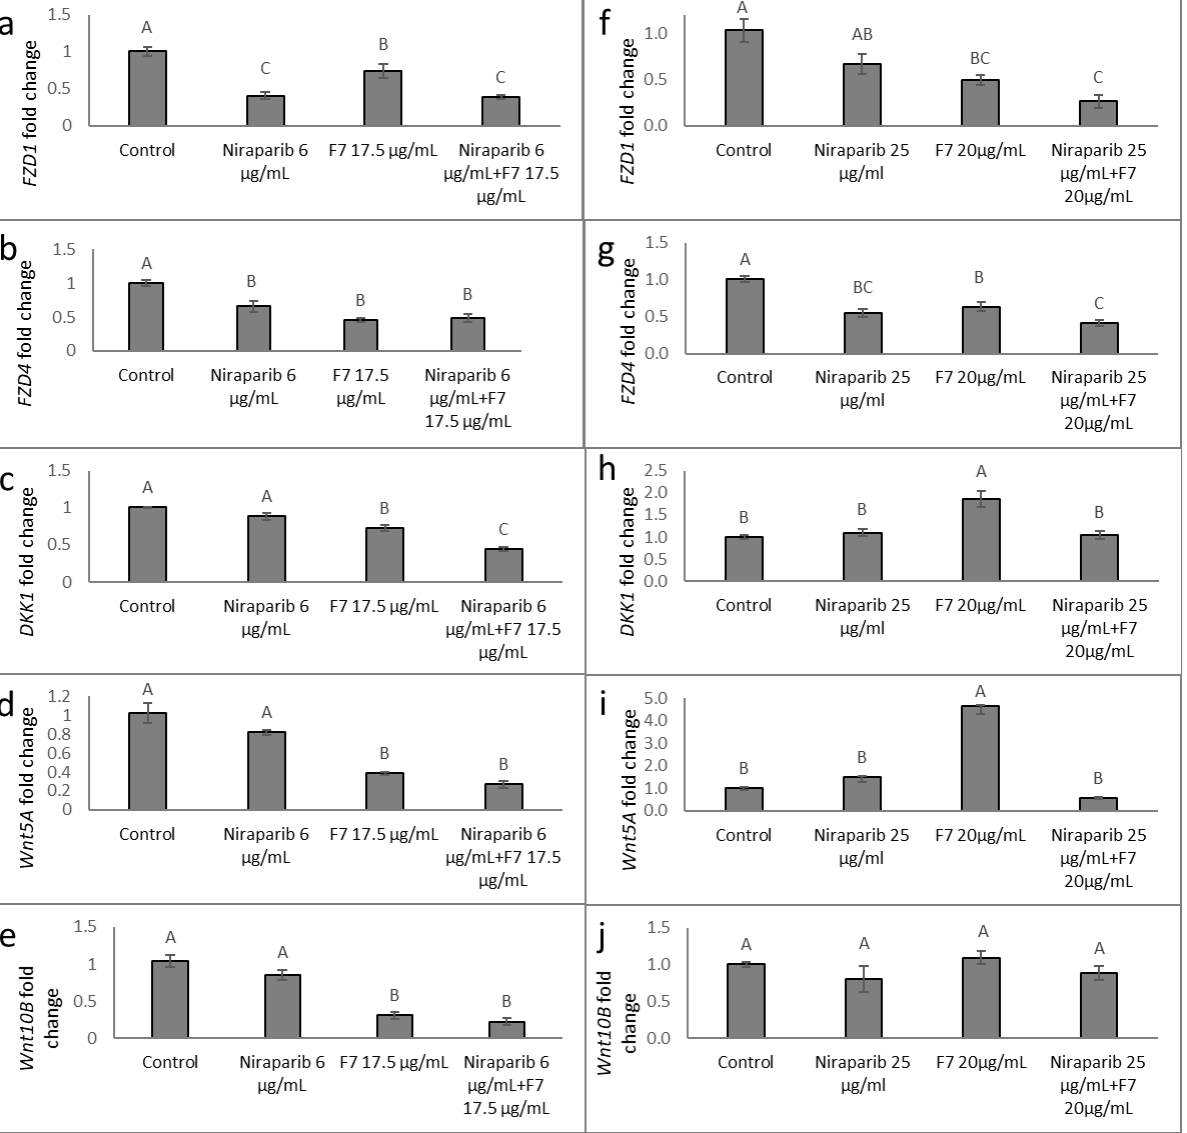
Figure 9. Quantitative PCR-based determination of the RNA steady state level in HTB75 ( a – e ) and HTB161 ( f – j ) cell lines of members of the FZD , DKK or Wnt gene families at 6 h of treatment with niraparib, F7, or a combination of niraparib+F7 relative to control. Gene transcript values were determined by quantitative PCR as a difference between the target gene versus a reference gene (HPRT). Values were calculated relative to the average expression of target genes in treated versus control using the 2 −ΔΔCt method. Control was the vehicle control (1.00% v/v methanol + 0.60% v/v DMSO). Error bars indicate ± S.E. ( n = 3). Levels with different Upper case letters with the same font and style were significantly different from all combinations of pairs by Tukey-Kramer honest significant difference (HSD; p ≤